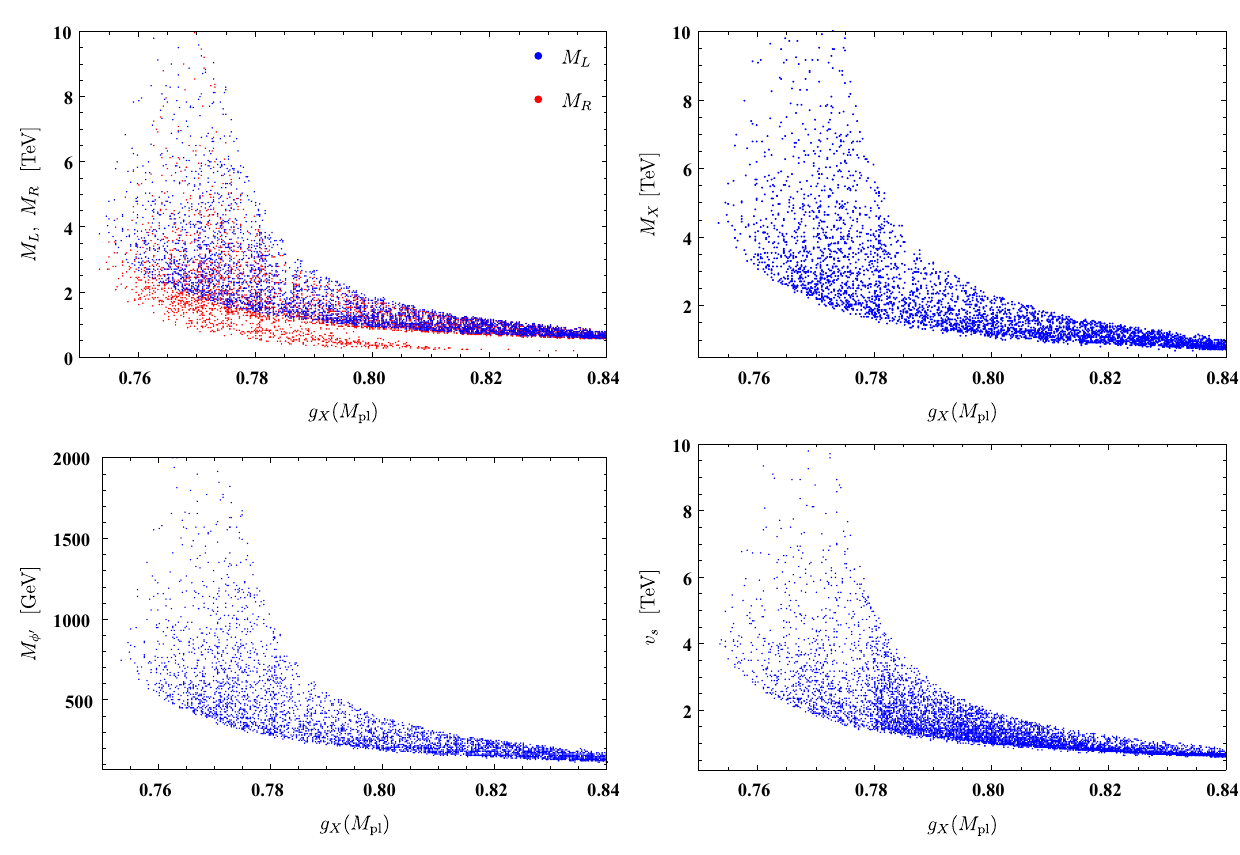
(cid:4) (cid:5) M pl